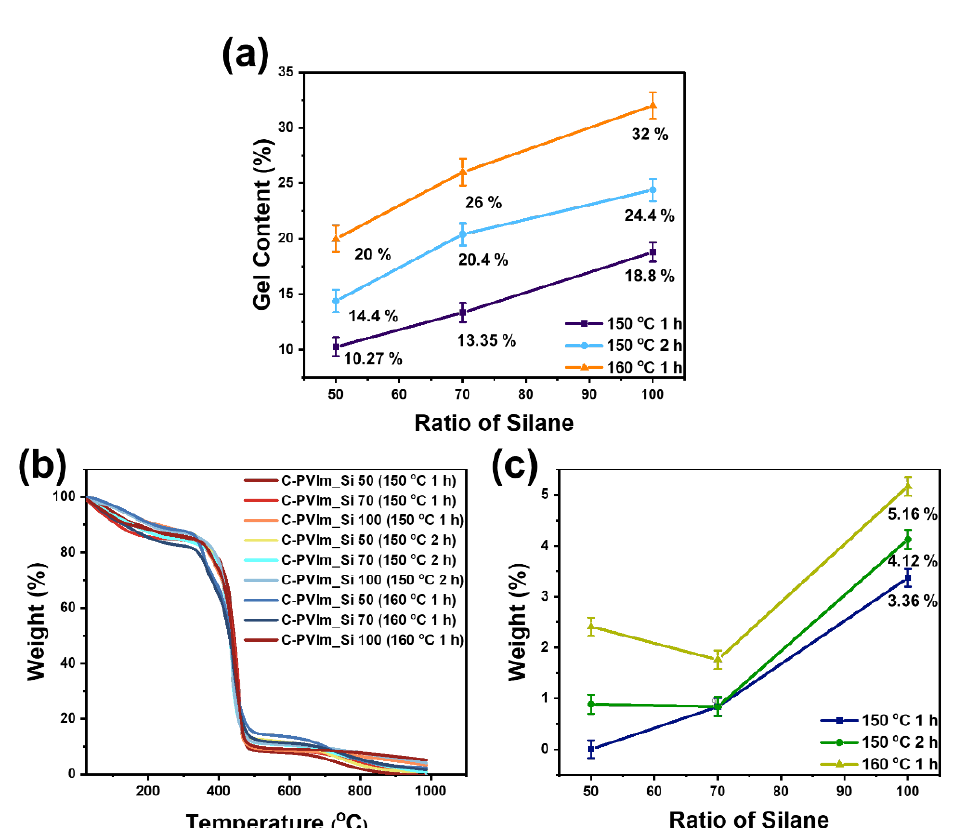
Figure 4. ( a ) Gel content of C-PVIm_Si; ( b ) TGA curves of C-PVIm_Si; ( c ) final weight based on TGA.